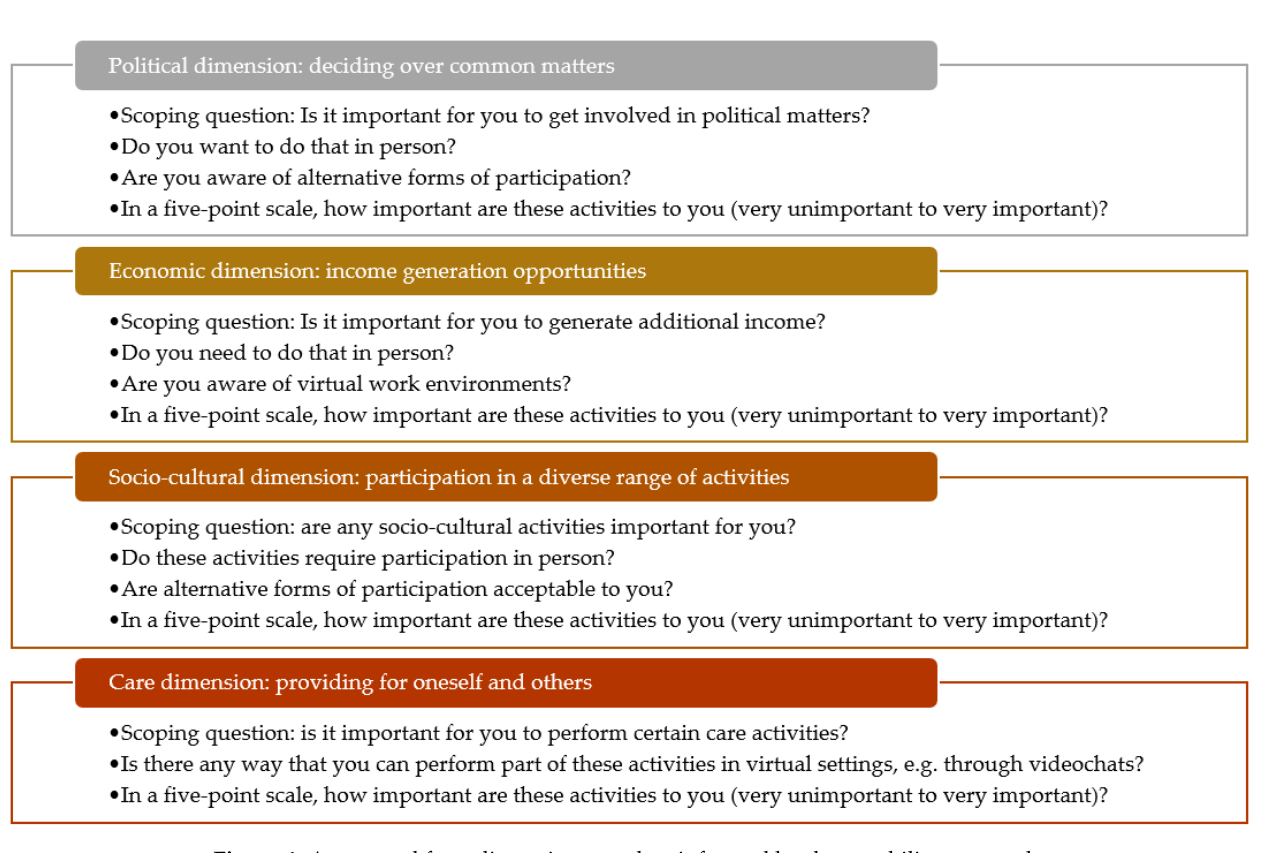
Figure 4. A proposal for a discussion template informed by the capability approach.